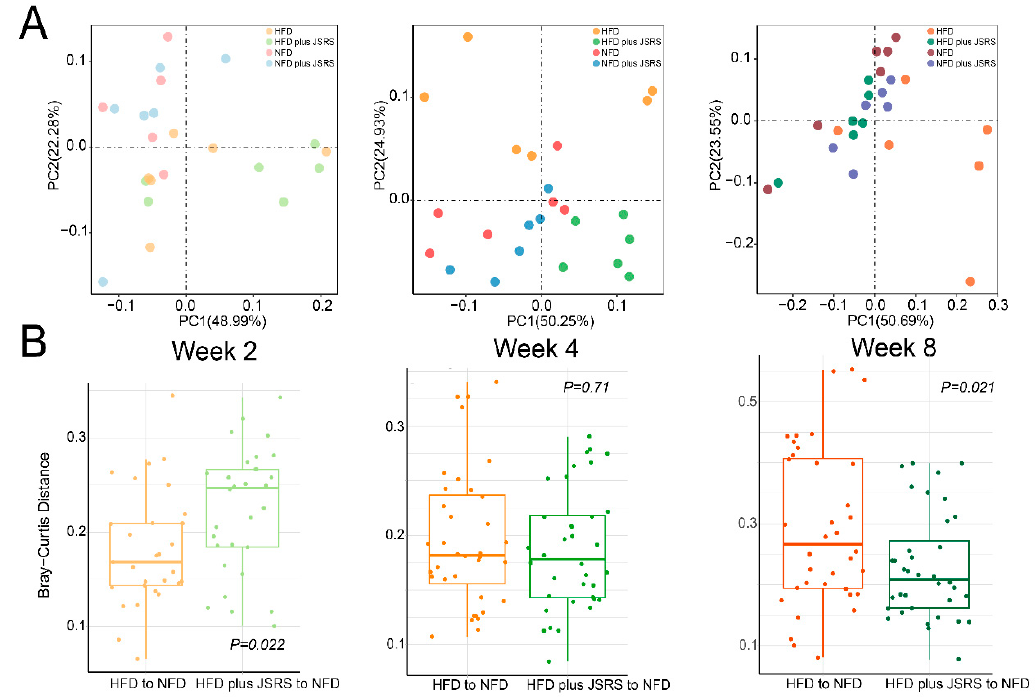
Figure 2. Changes in microbial structure and similarity at different time points. ( A ) Principal coordinate analysis (PCoA) showed the changes in microbial composition based on bray-curtis distance among four groups at weeks 2, 4, and 8 in Stage Ι . Each point represents the composition of the microbiota of one sample. ( B ) Comparison of the similarity between HFD group to NFD group and HFD plus JSRS group to NFD group based on Bray–Curtis distance at week 2, 4, and 8 in Stage Ι . Lower values indicate similarity to the NFD group. (JSRS, Jackfruit seed sourced resistant starch).